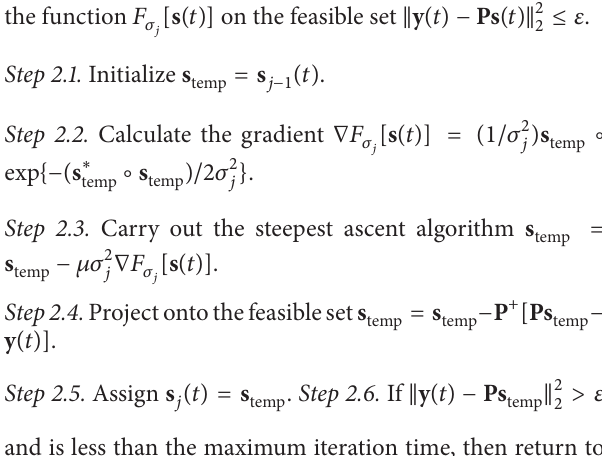
Algorithm 1 (compressed sensing reconstruction